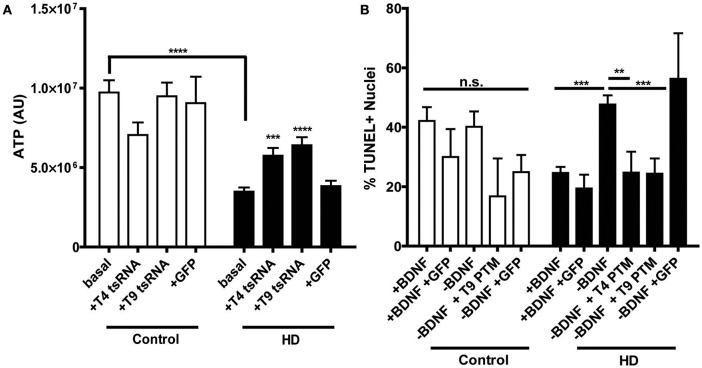
PTM expression in HD180 iPSC-derived neural cultures reverses established mtHTT phenotypes. (A) ATP levels in HD and control NPCs. Cells were dissociated and ATP levels were assayed in equal numbers of cells. Control NPCs had significantly more ATP than HD NPCs. However, expression of PTMs significantly increased ATP levels in the HD, but not control, NPCs. Expression of GFP did not significantly affect ATP levels. ***p < 0.001, ****p < 0.0001, one-way ANOVA. Data are plotted as means and SEM. At least three separate passages of NPCs were examined. (B) HD and control iPSCs, with or without PTMs, were differentiated toward a striatal fate for 42 days before BDNF was withdrawn for 24 h. Cells were fixed, assayed for TUNEL, and counter stained with Hoechst. The percentage of TUNEL-positive nuclei was calculated as a measure of toxicity. The HD180 iPSC-derived striatal cells showed more cell death after BDNF withdrawal than did control iPSC-derived striatal cells. However, BDNF withdrawal in the presence of PTMs, but not GFP, reversed this toxicity. **p < 0.01, ***p < 0.001, one-way ANOVA. Data are plotted as means and SEM. At least three fields per coverslip (three coverslips per experiment) were counted at random during at least three separate differentiation experiments.